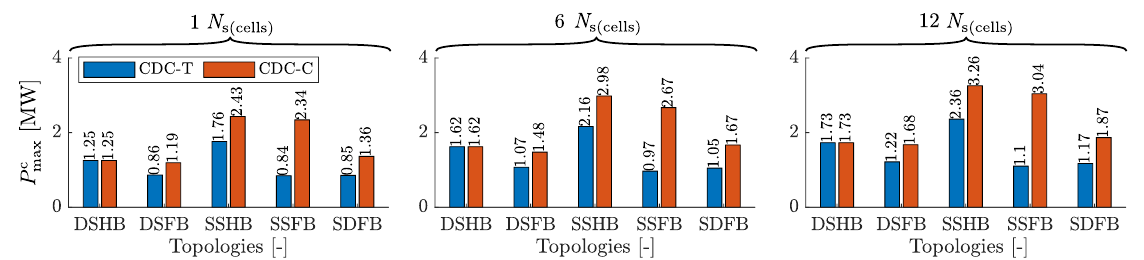
Figure 8. The maximum DC charging power considering the two different DC charging scenarios, CDC-T and CDC-C, for all topologies with 1, 6, and 12 N s(cells)